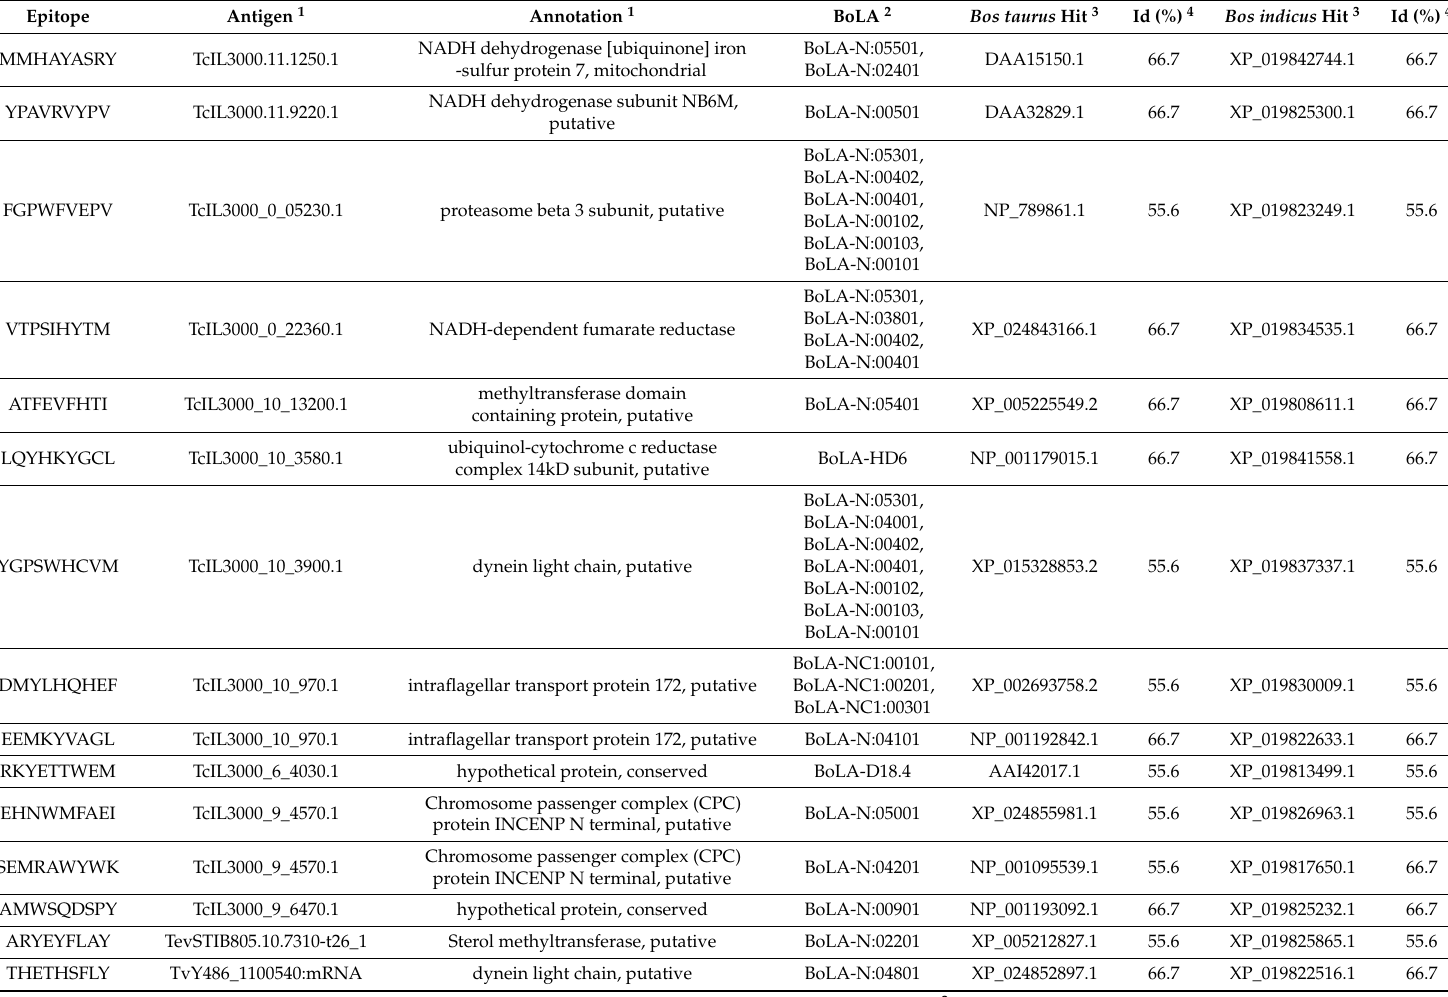
Table 3. List of the CD8 T-cell epitopes predicted in the invariant AAT-spp. proteome that were selected for the